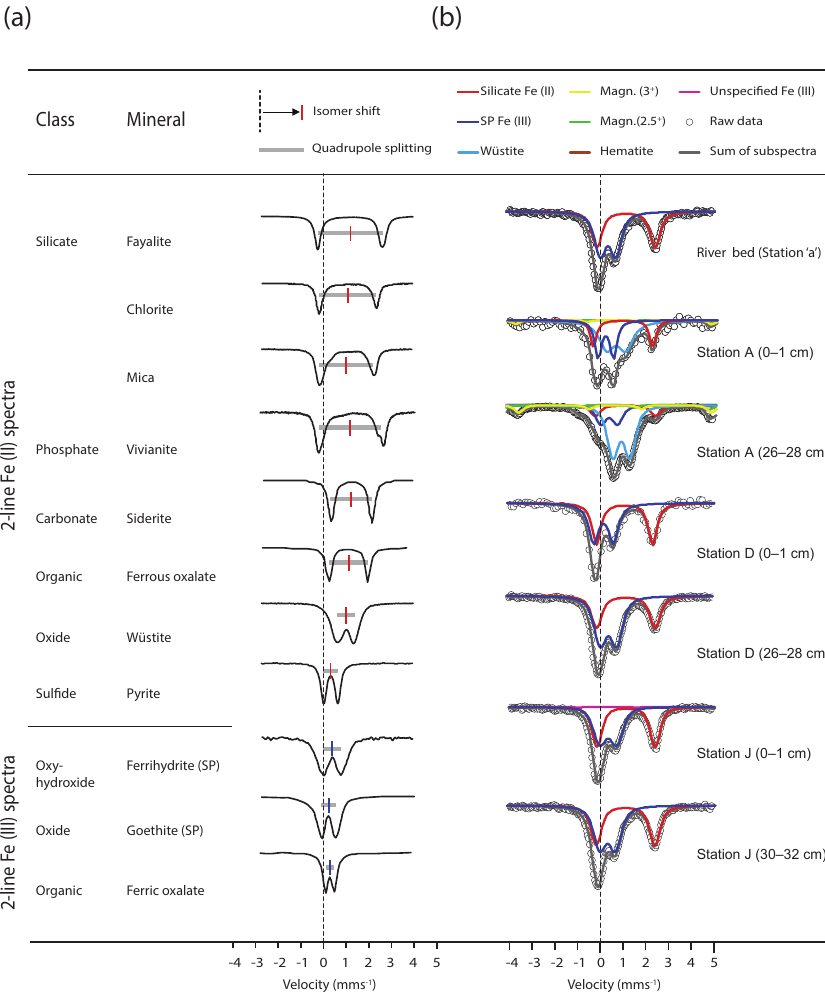
phases, it is difficult to deconvolve high-spin Fe (II)